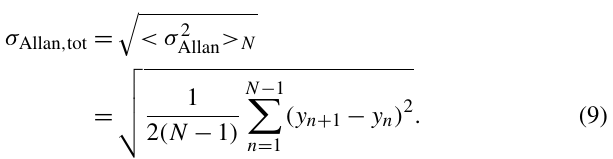
The total Allan deviation for N measurements is then written